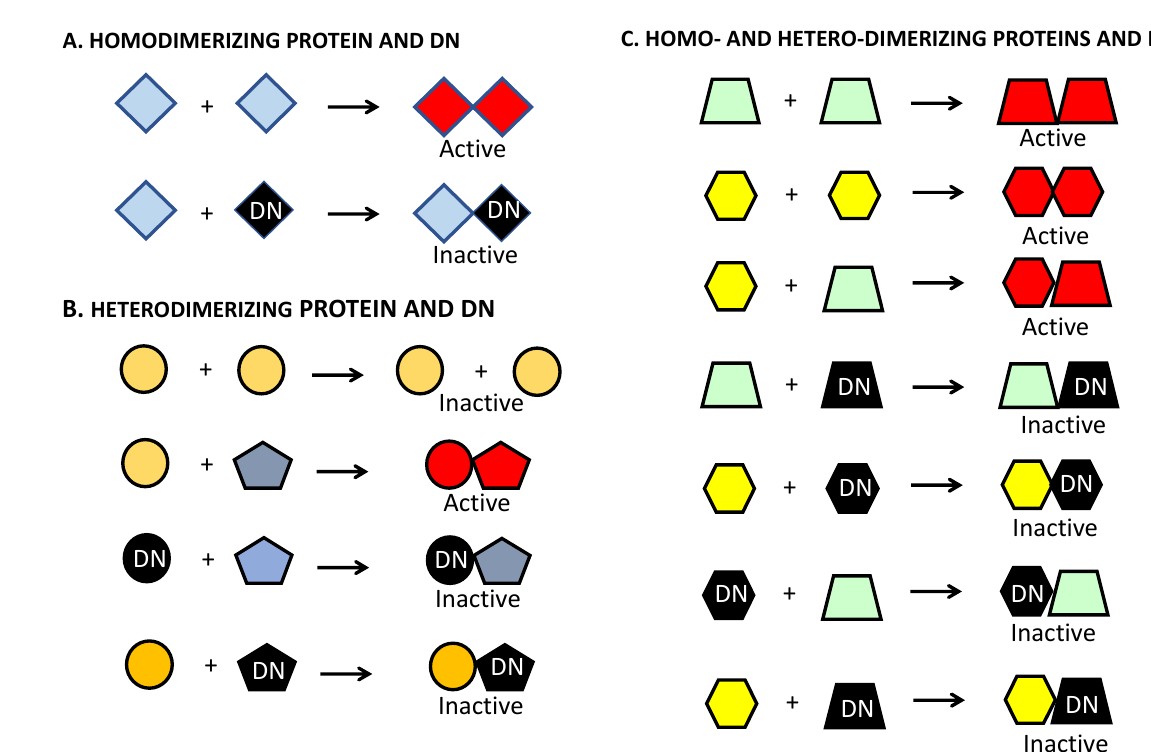
Figure 2. Examples of interference with transcription factor activity by dominant negatives (DN). A . A factor that is activated by homodimerization. Blue symbols depict inactive wild-type mono- mer; black symbols, DN mutant form of the same factor; red symbols, activated wild-type homodi- mer. The wild-type:DN heterodimer is inactive. B . A factor that does not homodimerize and is acti- vated by heterodimerization. Orange symbols depict inactive wild-type monomer; blue-gray sym- bols, wild-type inactive heterodimerizing partner; black symbols, DN mutant forms of each factor; red symbols, activated wild-type heterodimer. Heterodimers formed by either of the wild-types with DN forms of heterodimerization partners are inactive. DN-ATF5 appears to conform to this model. C . Two factors that are activated by homodimerizing and by heterodimerizing with one an- other. Green and yellow symbols depict inactive wild-type monomers; black symbols, DN mutant forms of each factor; red symbols, activated wild-type homo- and heterodimers. Heterodimers formed by each wild-type factor and its corresponding DN are inactive as are heterodimers formed by each wild-type factor and the DN of its wild-type heterodimerization partner. Dpep and Bpep appear to follow this mode.